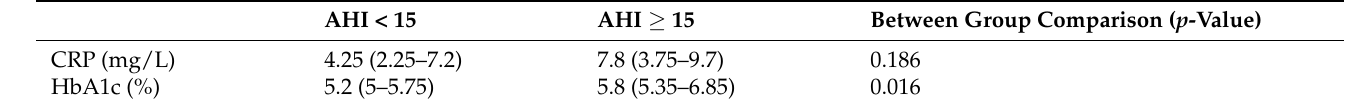
Table 3. C-reactive protein and glycated hemoglobin levels in obese individuals with mild or moderate to severe obstructive sleep